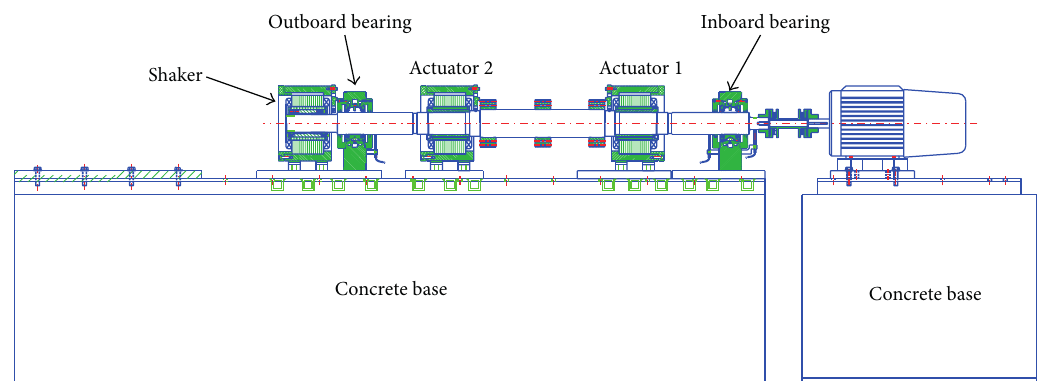
Figure 5: Test rig for stability of rotor supported by tilting pad bearing [11].